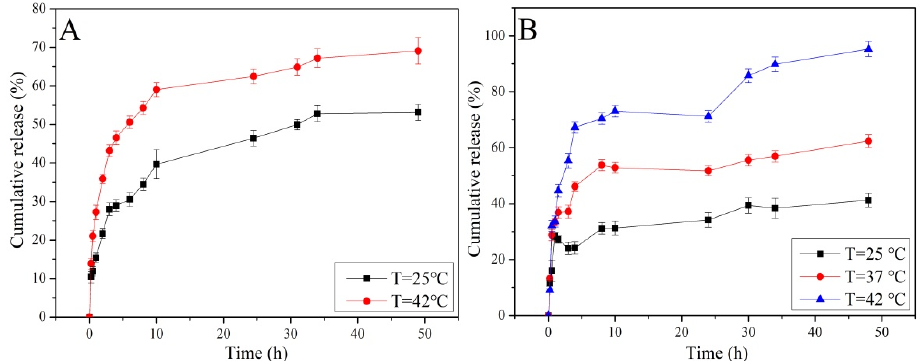
Figure 8. Release of DOX ( A ) and NAP ( B ) from nanocarriers at di ff erent